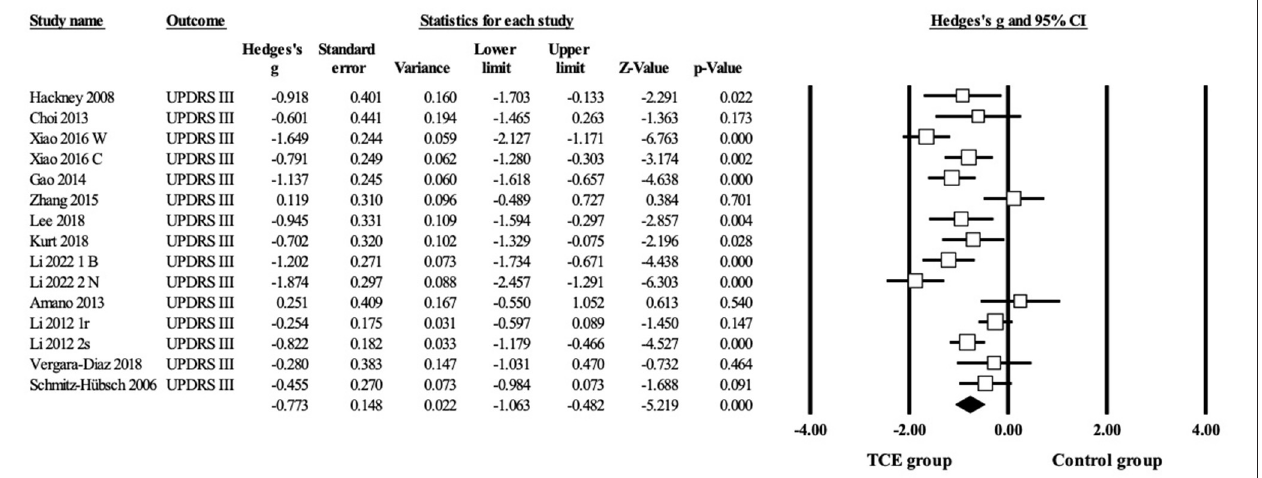
FIGURE 5 | Forest plot showing the effects of TCE vs. control group on motor symptoms: